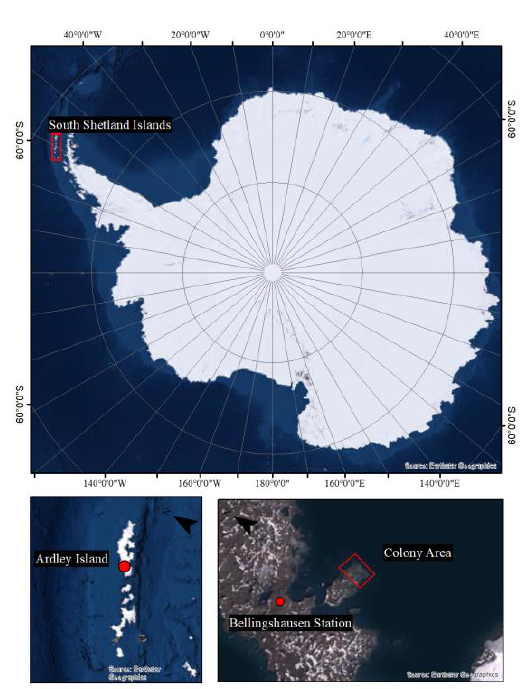
Figure 1. Position of the study area. © Earthstar Geographics 2018, NASA,